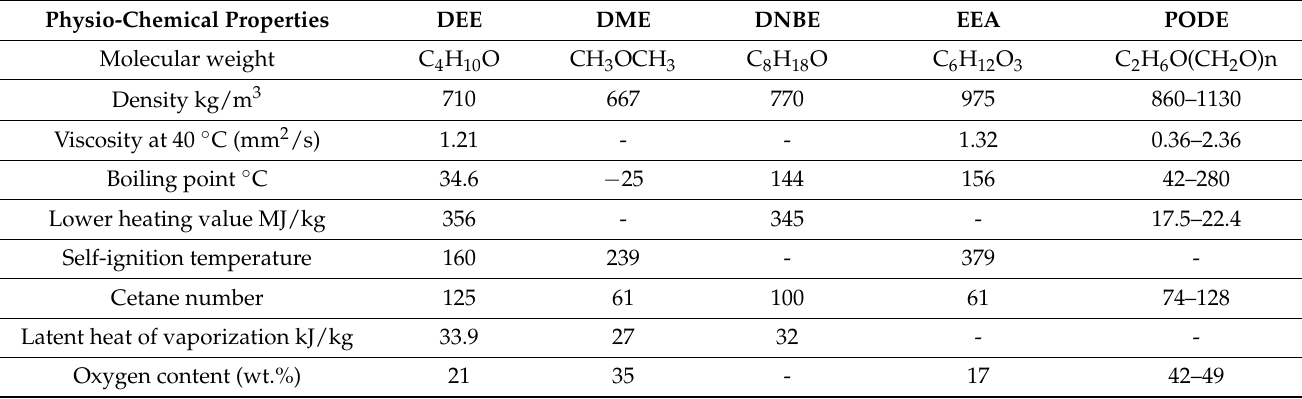
Table 3. Physio-chemical properties of ether-based additives [64–66].